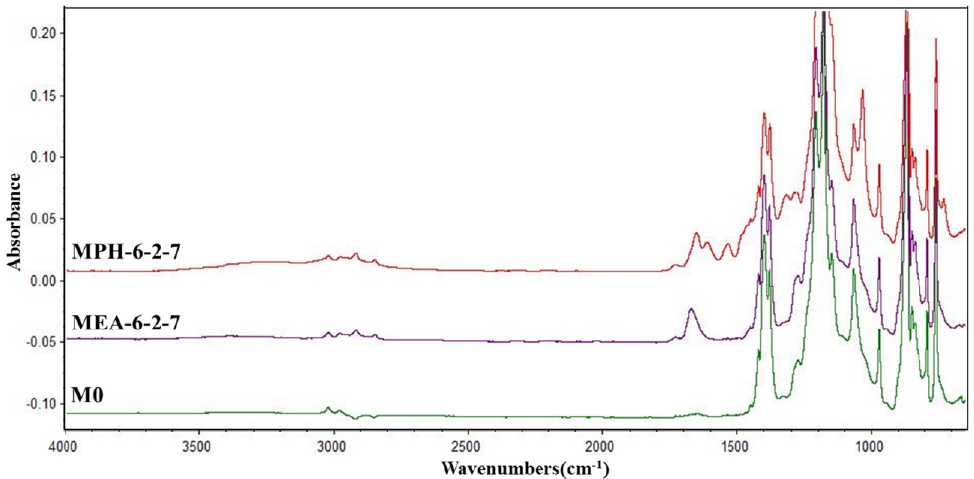
Figure 9. ATR-FTIR spectra of MPH-6-2-7 and MEA-6-2-7 after cleaned in 500 mg/L NaClO solution for 16